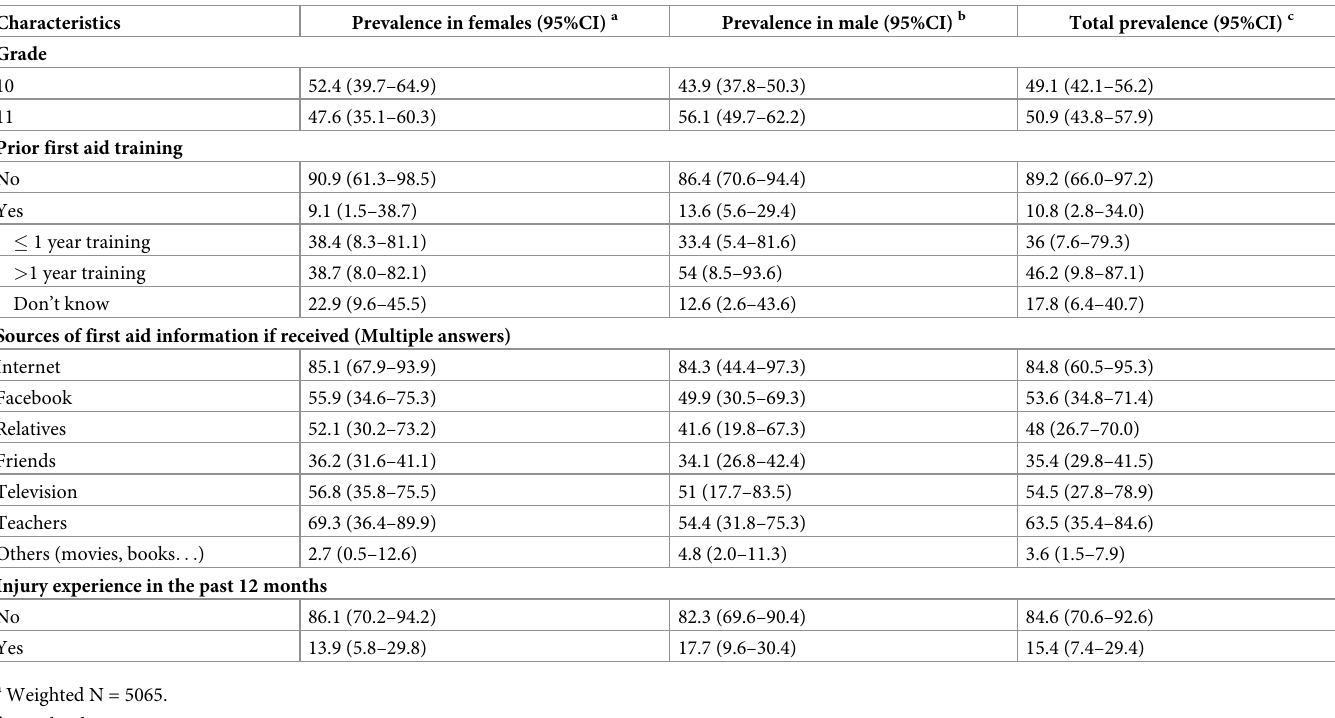
Table 1. The weighted characteristics of students by